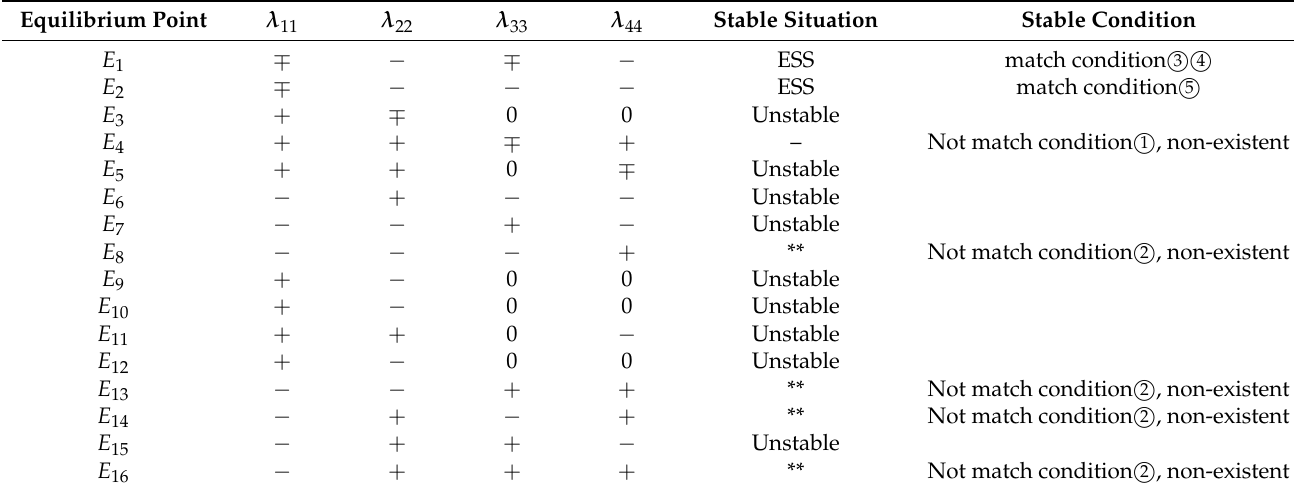
Table 3. Analysis of stable condition of ESS of quadripartite evolutionary game replicated dynamic system. Equilibrium Point λ